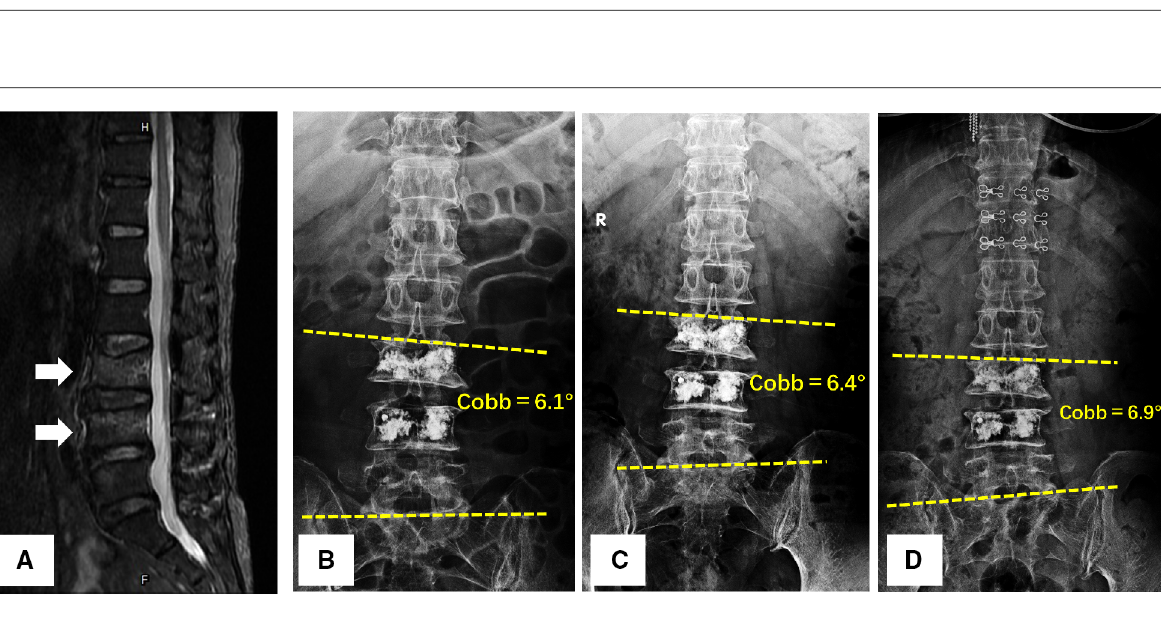
FIGURE 3 A 58-year-old female was diagnosed with L1 and L3 vertebral compressed fractures treated with unilateral PVP. ( A ) Preoperative T2-weighted MRI scan showed a higher-intensity signal within the fractured vertebral body; ( B – D ) 24 h after surgery, 6-month follow-up, and 48-month follow-up anteroposterior x -rays of lumbar spine, a progressive Coronal Segmental Cobb angle was observed with time.